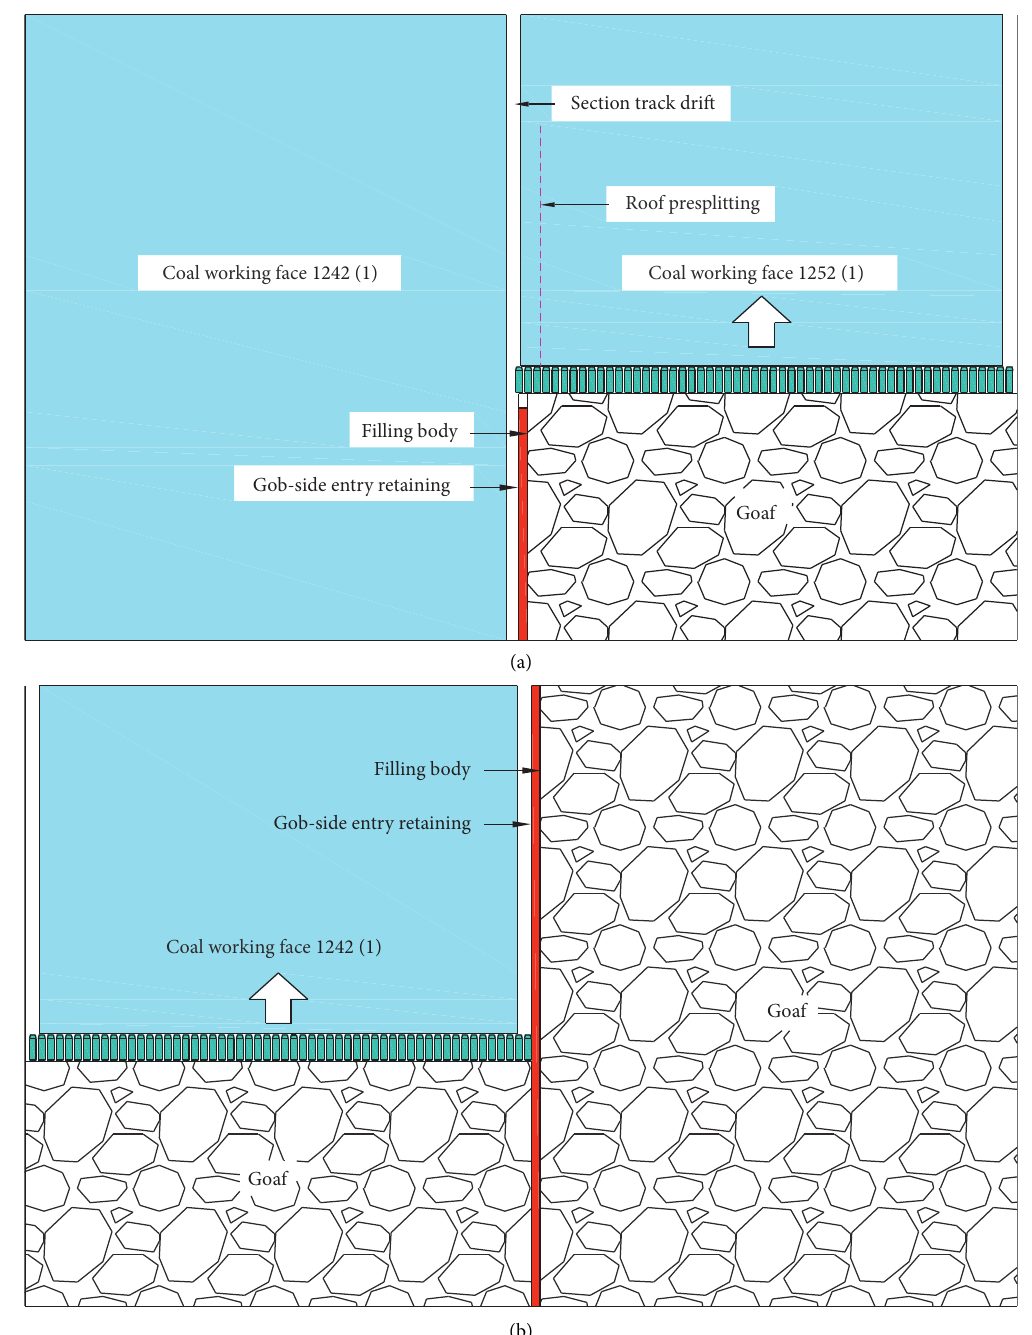
Figure 1: Roadway layout of two coal working faces. (a) In the stage of gob-side entry retaining; (b) in the reuse process of gob-side entry